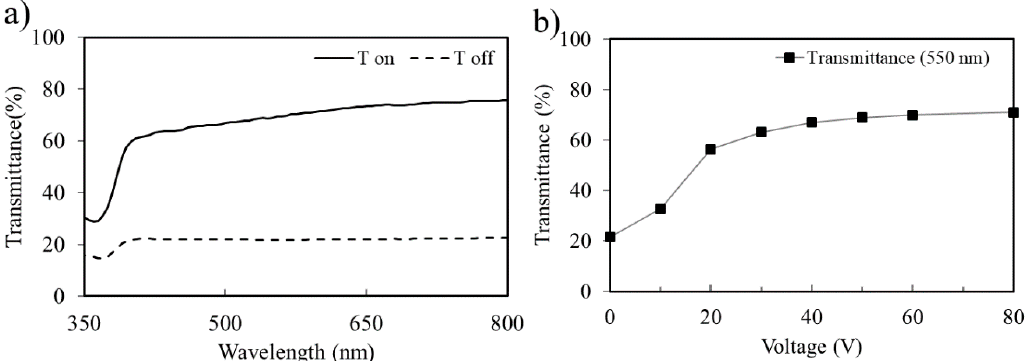
Figure 12. ( a ) The optical transmittance of the Cu–Ni NWs in the “ON” and “OFF” states for wavelengths ranging from 350 to 850 nm. ( b ) The transmittance of the Cu–Ni NW-based PDLC smart window with increasing applied voltage at 550 nm.